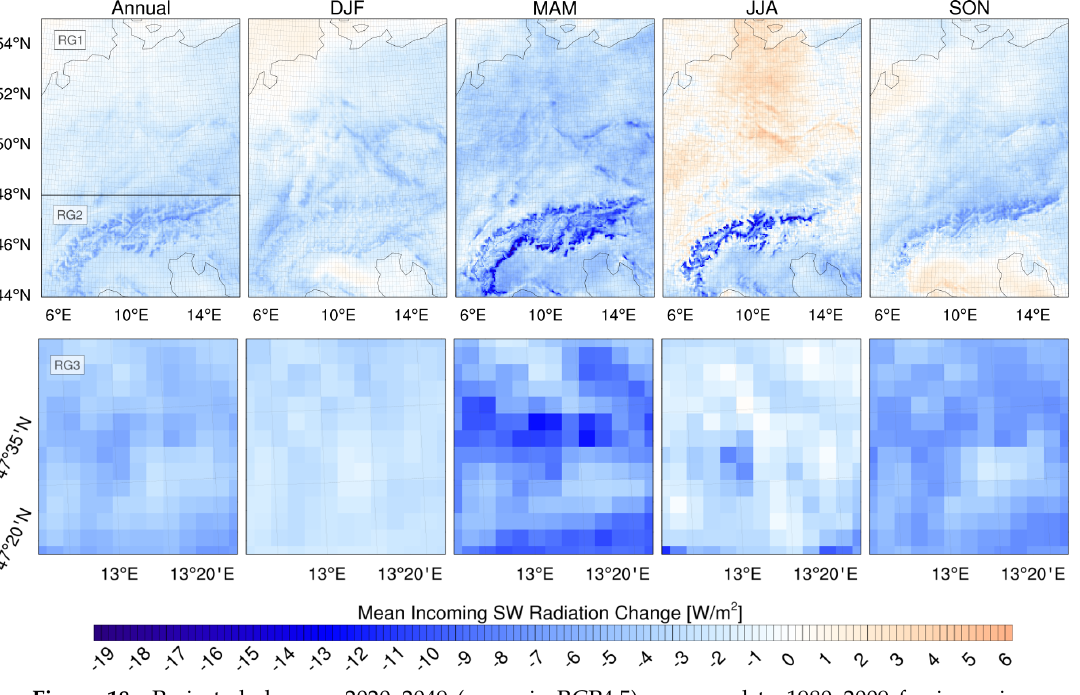
Figure 18. Projected changes 2020–2049 (scenario RCP4.5) compared to 1980–2009 for incoming short-wave radiation over RG1, RG2 (top row), and RG3 (bottom row). Annual, winter (DJF), spring (MAM), summer (JJA), and fall (SON) changes are displayed (from left to